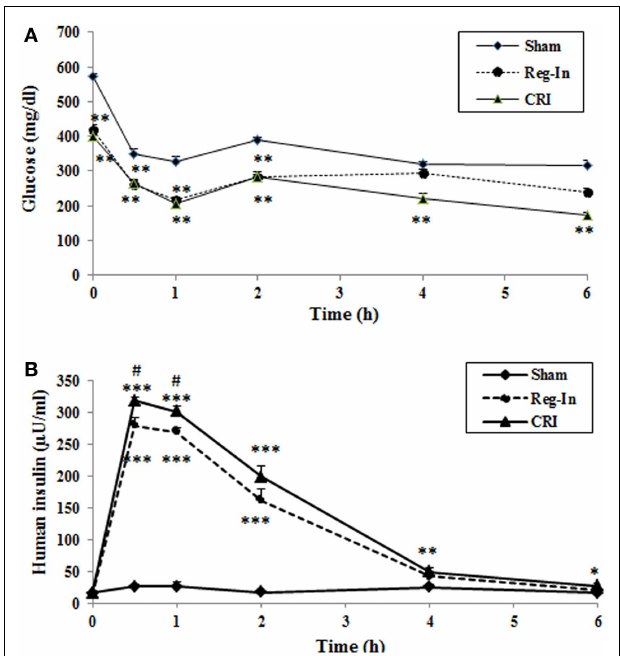
FIGURE 2 | Effects of Reg-In and CRI on glucose metabolism as well as their pharmaceutical kinetics dynamics study in KKAy mice . At week 7, KKAy mice were sub-muscularly injected insulin at dose of 2U/kg body weight. Blood samples were collected at various time points as indicated in the legends. Data were presented as mean ± SEM ( n = 8/group). * P < 0.05 and ** P < 0.01 and ***Sham vs. Regular-In or CRI. # P < 0.05, ## P < 0.01 and ### P < 0.001, Reg-In vs. CRI vs. Reg-In group.